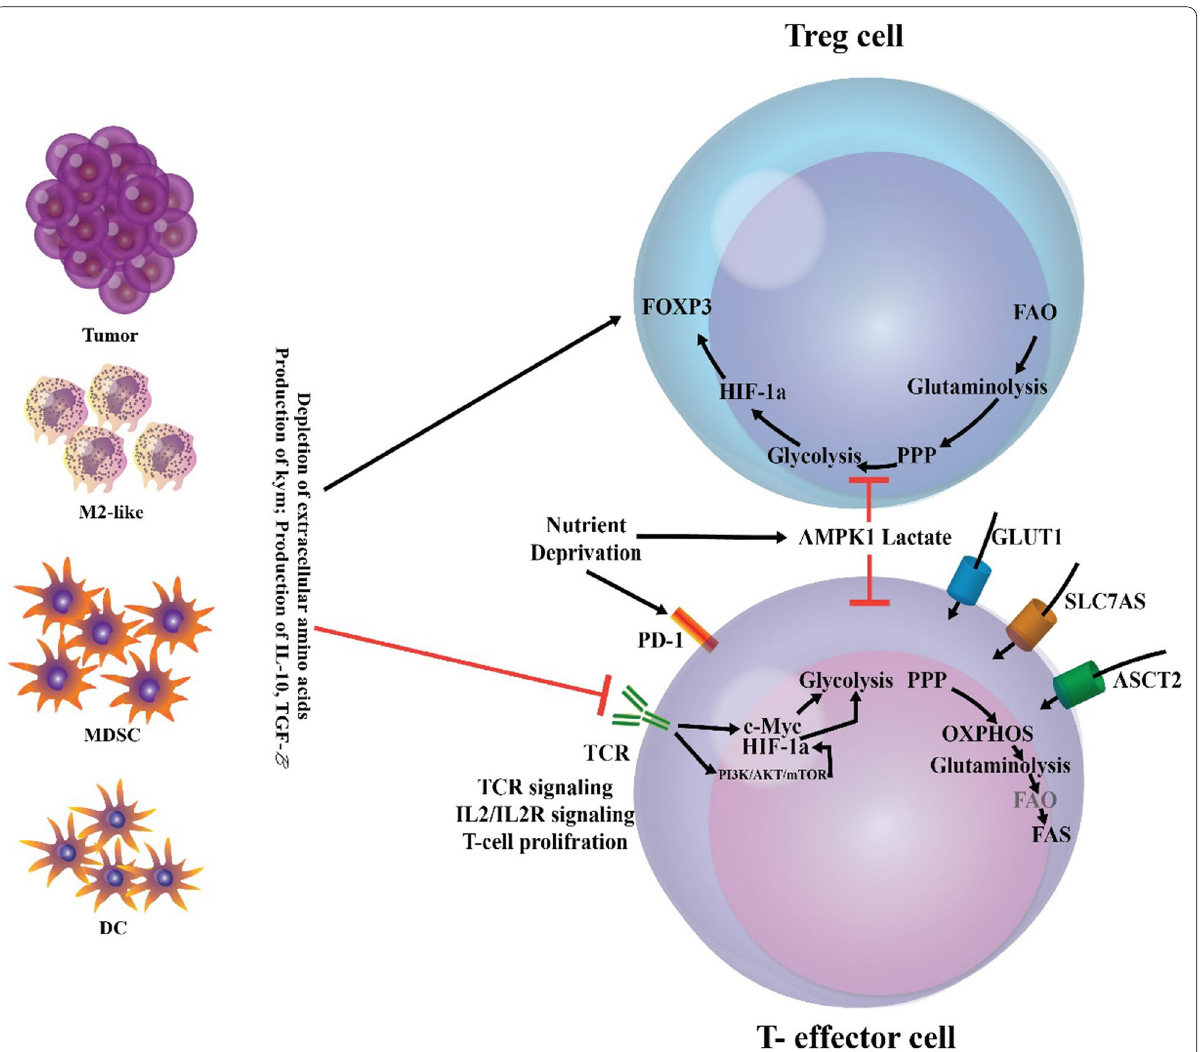
Fig. 6 Inhibition of T effector cells and activation of Treg cells by the tumor microenvironment. Nutrient deprivation-induced AMPK activation, depletion of extracellular amino acids, and lactate accumulation inhibit TCR signaling and downstream glycolysis that inhibits T effector cells. Inhibition of glycolysis, activation of OXPHOS, fatty-acid oxidation (FAO), and tumor microenvironment-related factors (e.g., hypoxia, Kynurenine (Kyn), TGF-b, and IL-10) instead activate Treg cells, which causes immune evasion and tumor growth (Biswas 2015). Arg, Arginine; Orn, Ornithine; Trp, tryptophan; Gln, glutamine; NO, nitric oxide; FAS, Fatty acid